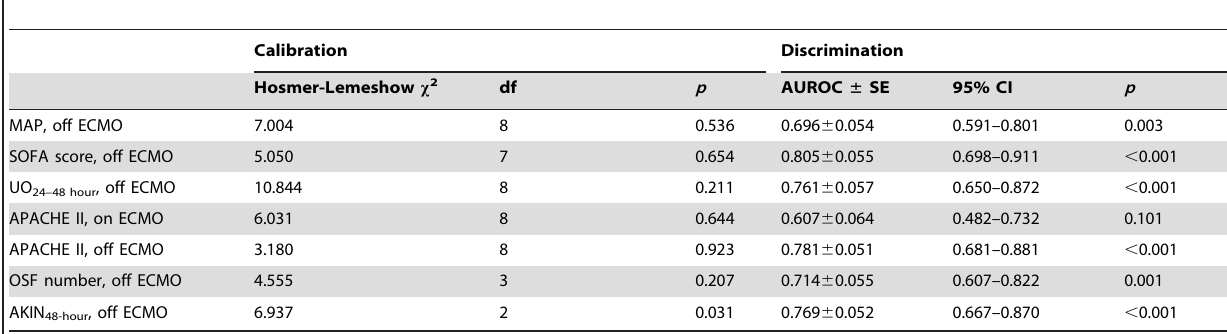
Table 3. Comparison of calibration and discrimination of the scoring methods in predicting hospital